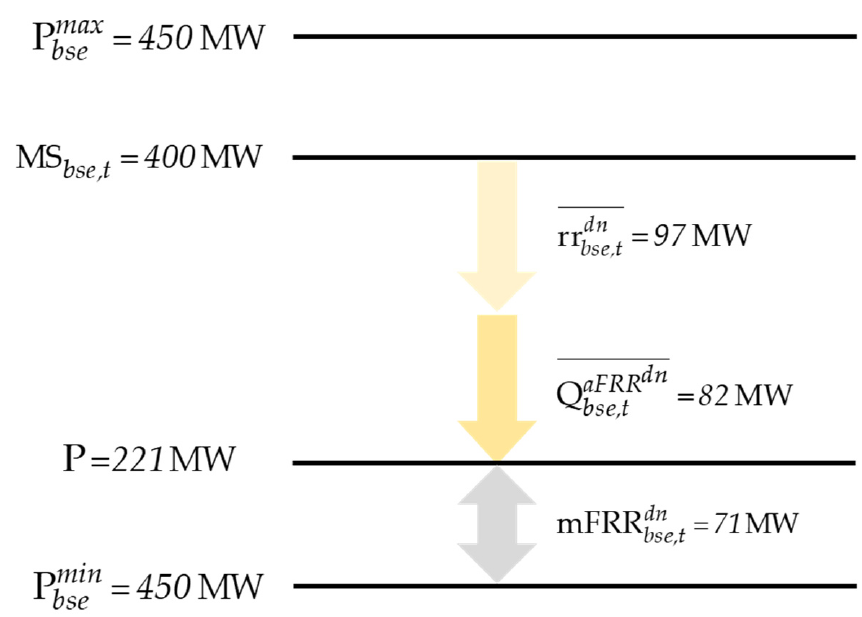
Figure 7. Conversion of downward BEO before submitting to the mFRR BE clearing platform. Regarding the results of the mFRR BE clearing process, Figure 8 provides the mar- ket clearing prices (MCPs) in the two above-defined cases; as shown, in the decoupled mode, there are significant differences in the attained MCPs with large MCPs attained in several countries (e.g., Italy, Norway and Netherlands), whereas in the coupled mode there is a significant leveling of the attained MCPs at the level of 70–100 EUR/MWh in all of the countries. The most significant changes include the three above-stated countries (Italy, Norway and Netherlands), where the final attained MCPs are equal to 76.58 EUR/MWh ( − 80.80% compared to the initial MCP which is equal to 398.88 EUR/MWh), 76.68 EUR/MWh ( − 77.43% compared to the initial MCP which is equal to 339.77 EUR/MWh) and 76.58 EUR/MWh ( − 72.30% compared to the initial MCP which is equal to 276.45 EUR/MWh),